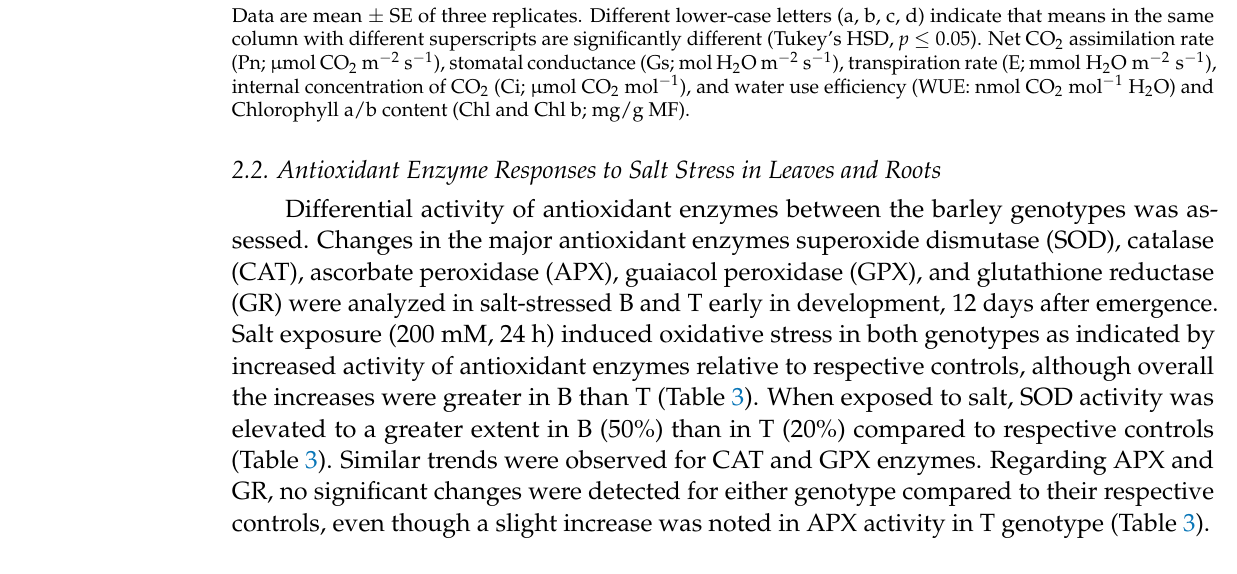
Table 3. Antioxidant enzyme activities in leaves of control and salt-stressed